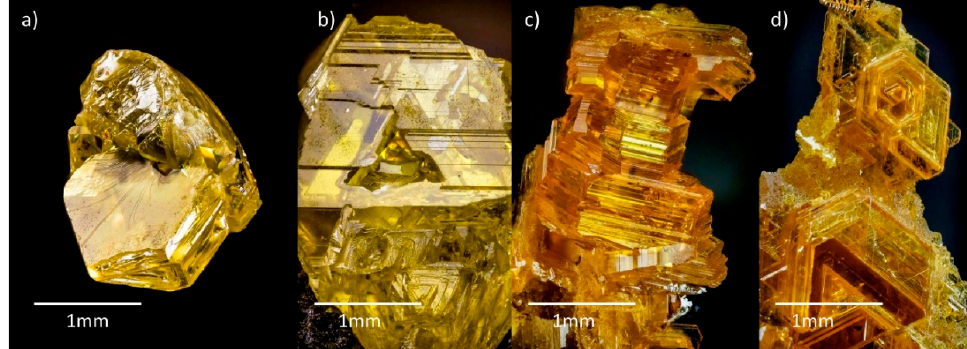
Figure 32. Microphotos of the yellowish sphalerite crystals with admixture of In and Au, synthesised at various f S 2 , see Table 25 for details. ( a ) Sample 2289, ( b ) sample 2290, ( c ) sample 2291, ( d ) sample 2292. Table 25. Concentration of In and Au according to LA-ICPMS data (ppm ± 2 σ ) in the crystals grown using the gas transport method with various fugacity of sulphur at 850 °C.